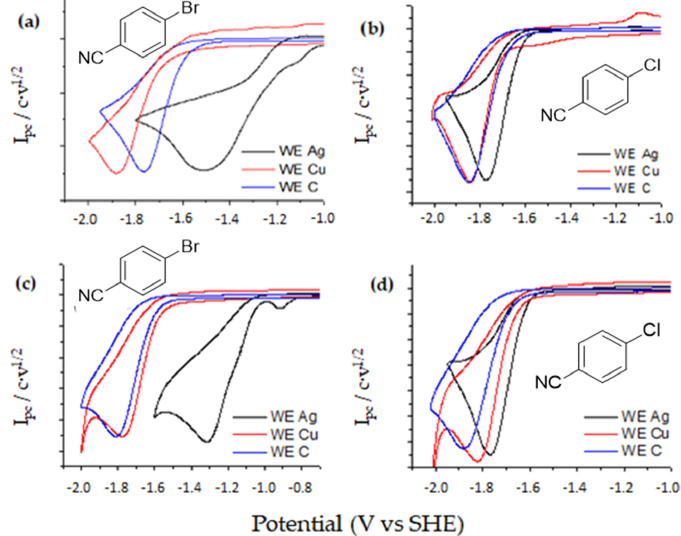
Figure 5. Cyclic voltammetry of 10 mM p -cyano compounds 6 and 7 in DMF / 0.1M TBA BF 4 with Ag